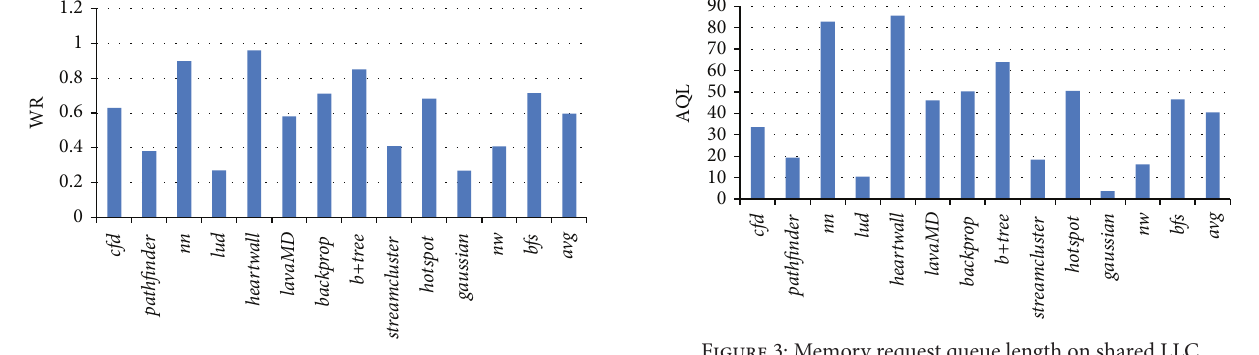
Figure 2: LLC queue waiting ratio.